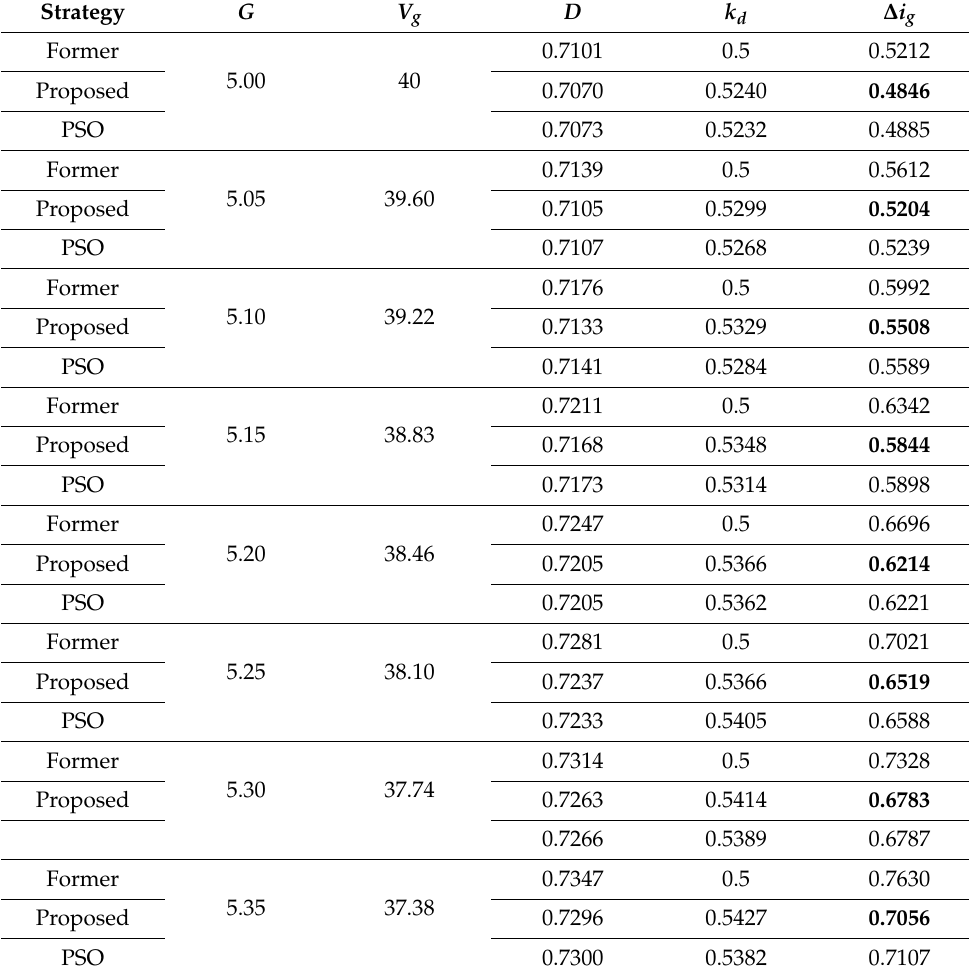
Table 8. Experimental results of the former, the PSO, and the proposed method.